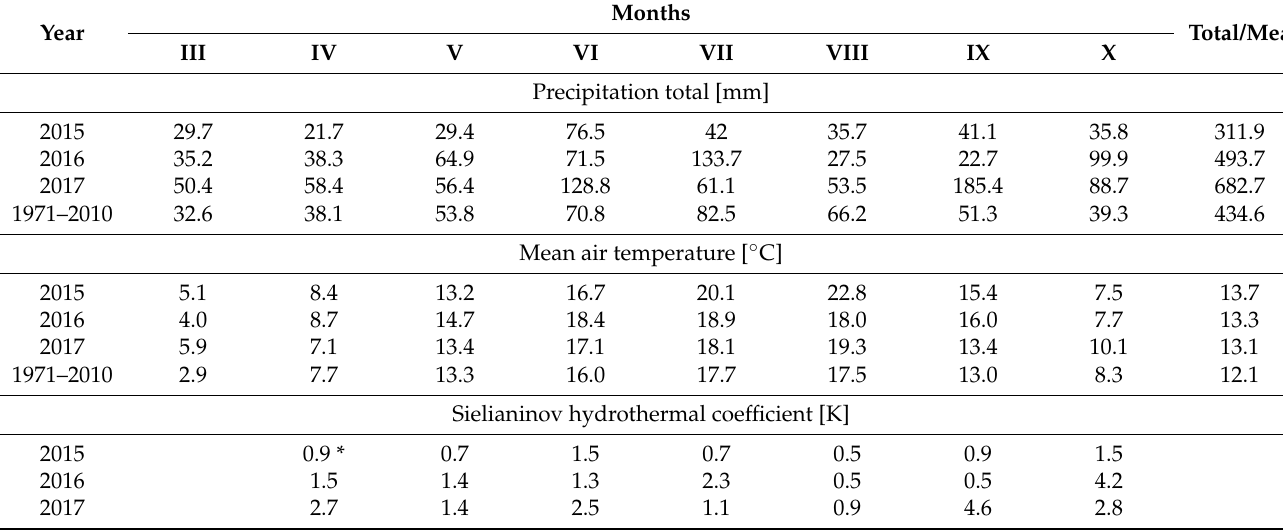
Table 2. Precipitation totals and mean air temperatures at 2 m above sea level, in the growing months in the years 2015–2017, in the Siemkowice region (according to the Institute of Meteorology and Water Management National Research Institute in